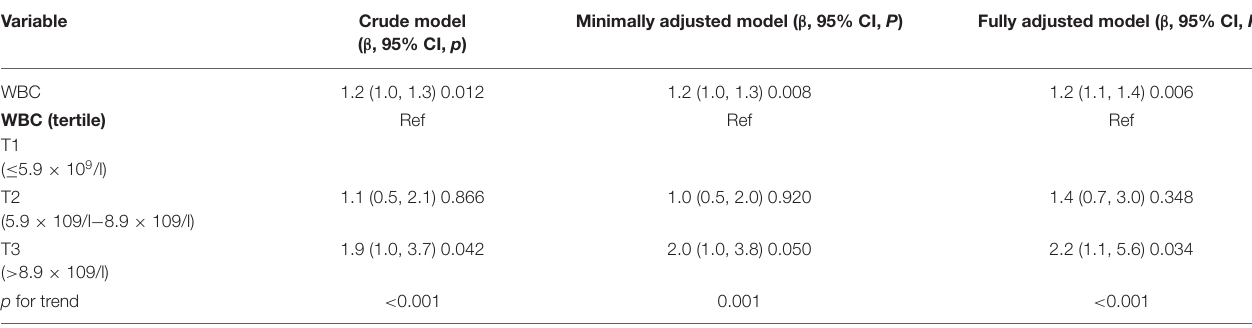
TABLE 3 | Relationship between WBC count and MTX treatment failure in different models.